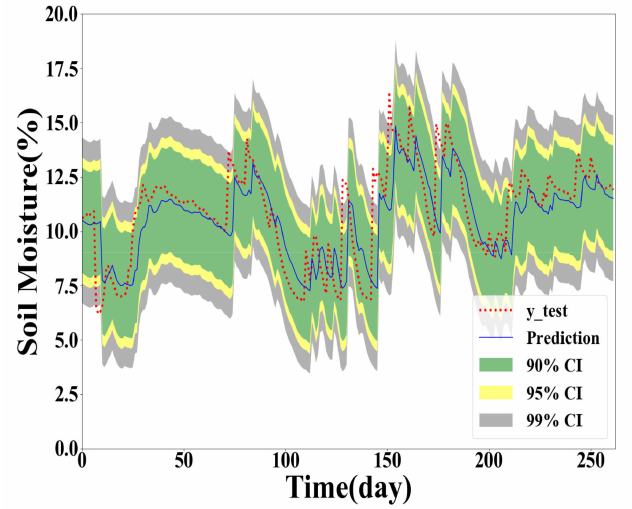
Figure 7. GPR model built with full training data in Y(3) prediction.